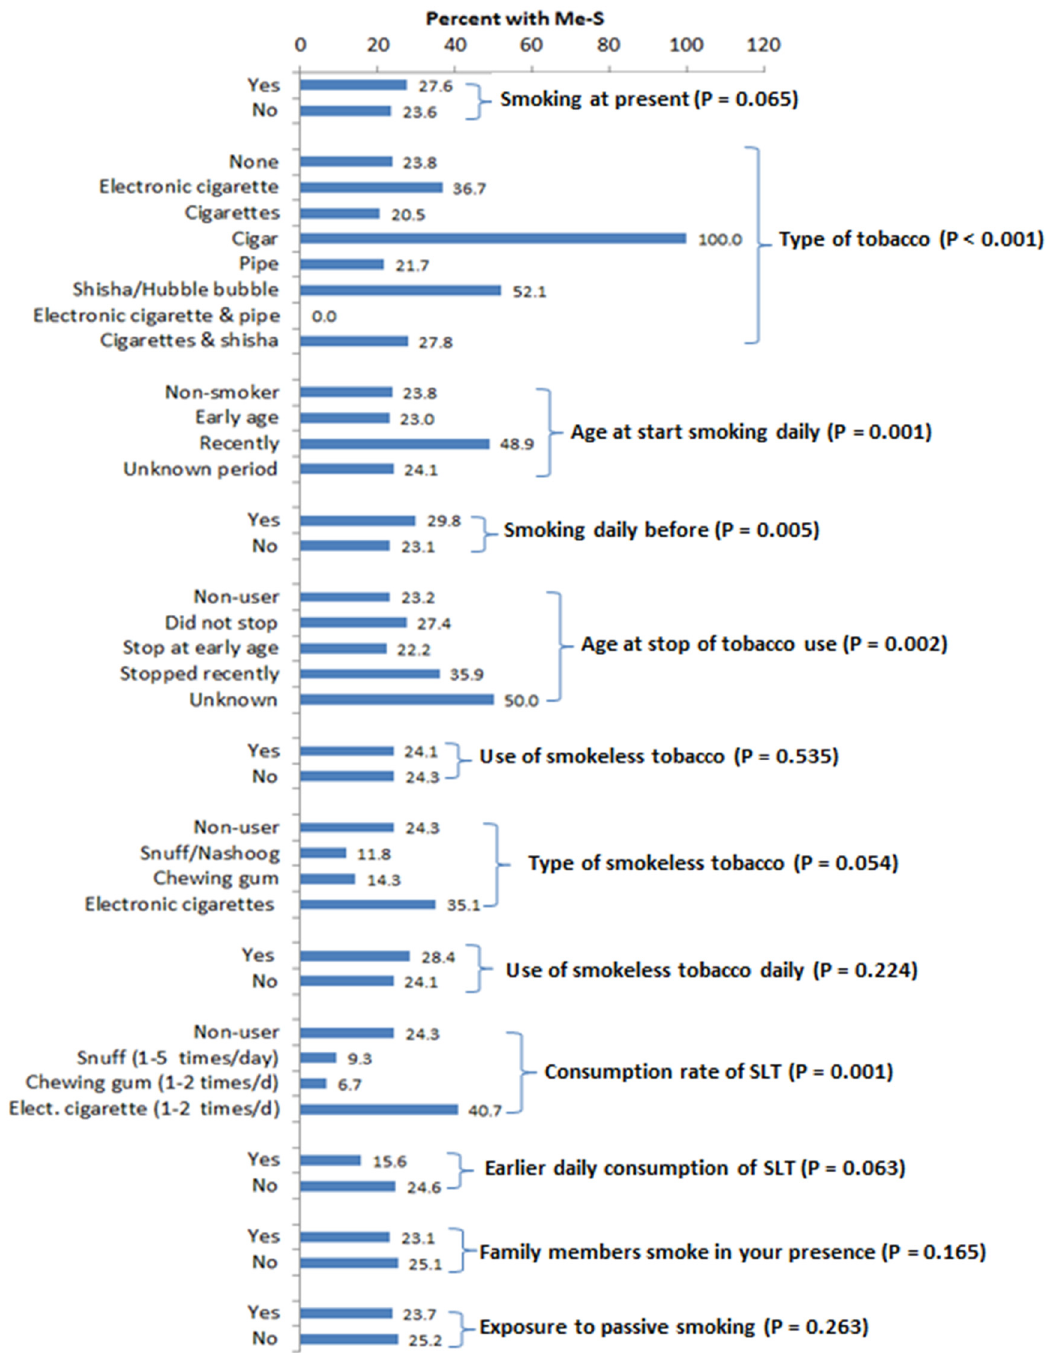
Figure 1: Association between Met - S and smoking habits or use of tobacco. Values are percentage frequency of Me - S in the same